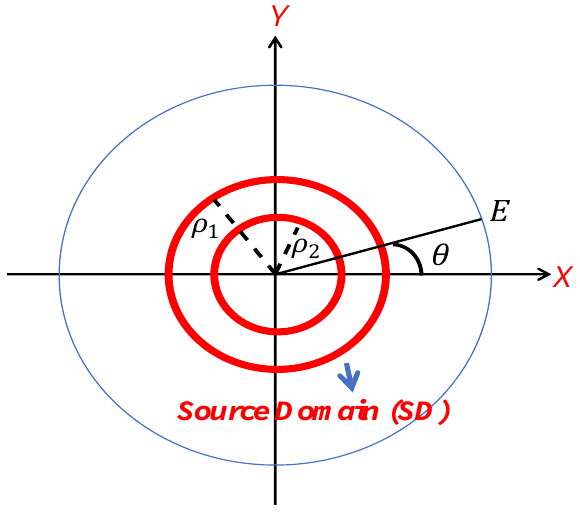
Figure 1. The geometry of the problem.